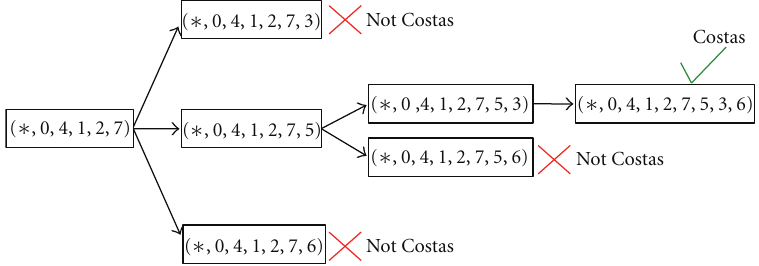
Figure 3: Backtracking search tree for MPCAs in ( Z 3 ) 2 with P init = ( ∗